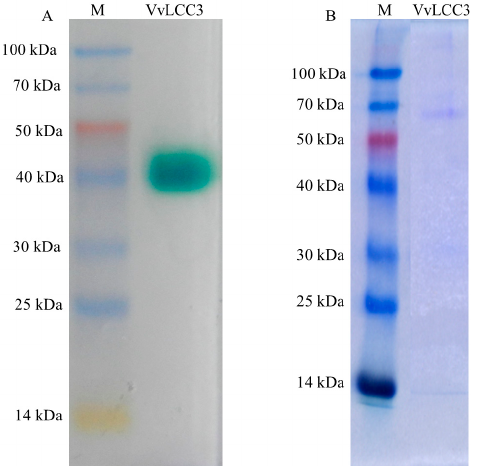
Figure 7. Native-PAGE and SDS-PAGE of purified VvLCC3 secreted by P. pastoris . M: protein marker, VvLCC3: laccase expressed in P. pastoris GS115. ( A ) Native-PAGE of purified VvLCC3